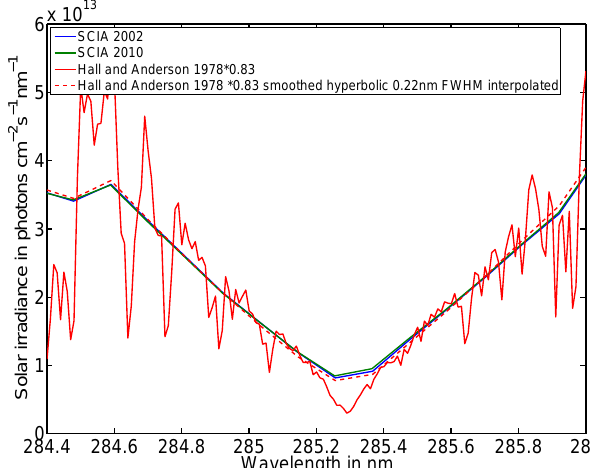
Fig. 10. The high resolution spectrum from Fig. 9 is smoothed and scaled for the SCIAMACHY spectrum by a factor of 0.83, so that the peak edges of the spectra are in agreement.